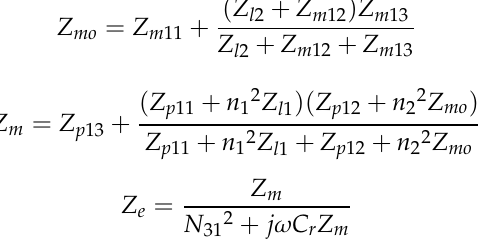
Figure 4. Electromechanical equivalent circuit of a radial composite tubular transducer.